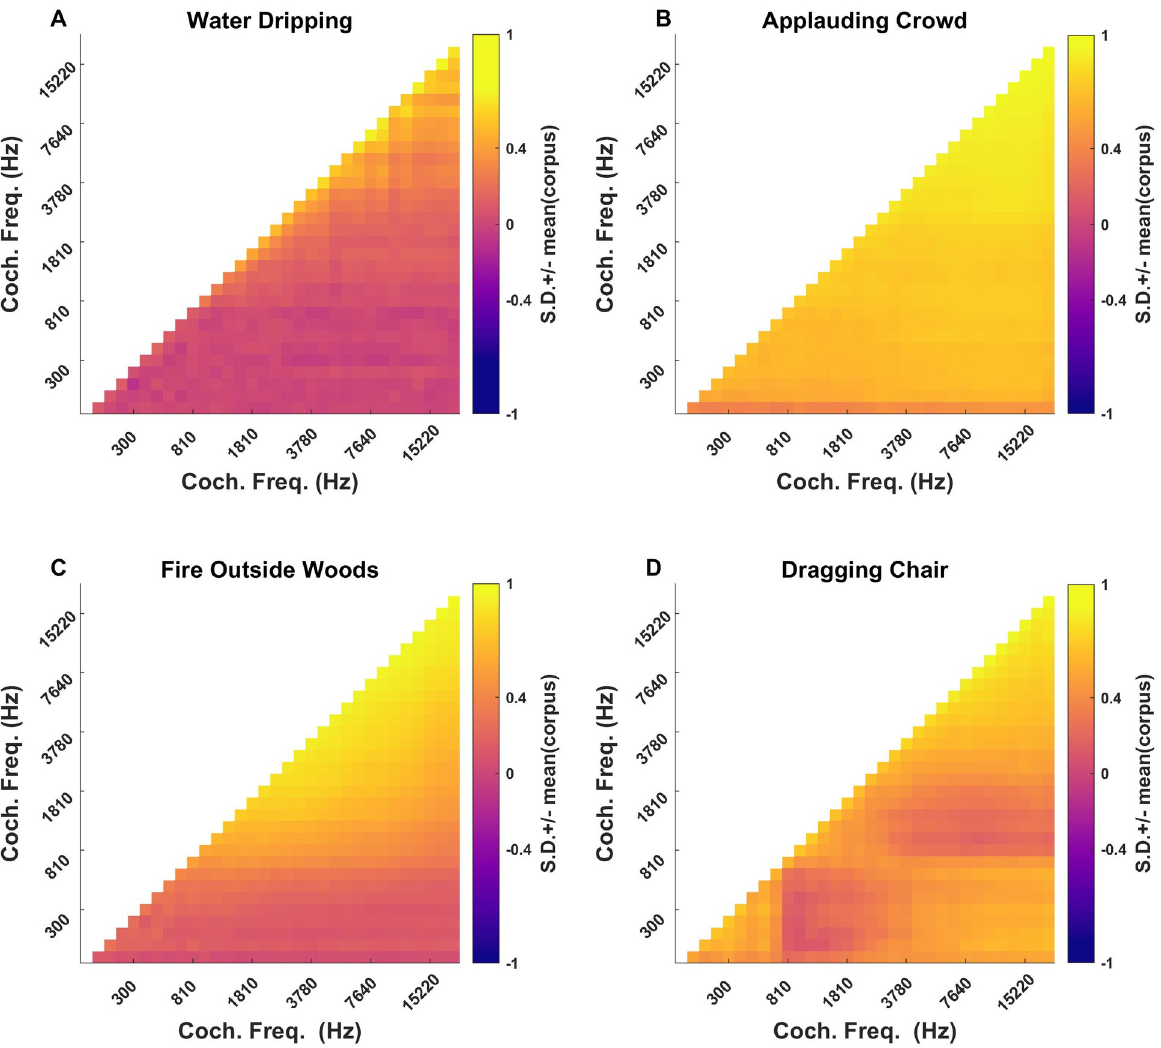
Fig 8. Heatmaps of the correlation statistics of selected sounds. (A) ‘Water Dripping’, with a very small PC1 value for cochlear correlations, has substantially lower cochlear correlations throughout than ‘Applauding Crowd’ (B), which has a very high PC1 value. (C) and (D) show the correlation matrices of ‘Fire Outside Woods’ and ‘Dragging Chair’ respectively, which lie near opposite ends of PC2 of the cochlear correlations. For ‘Fire Outside Woods’ high correlations are largely confined to the upper frequency bands only, while for ‘Dragging Chair’, sizeable correlations between high and low frequencies are also